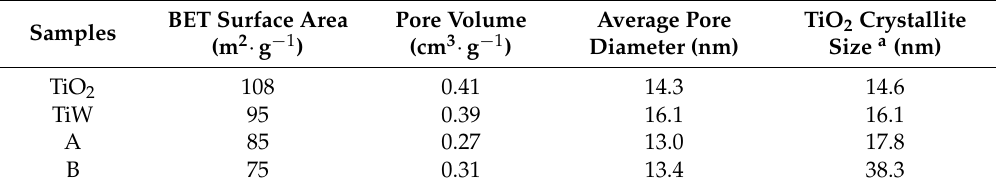
Table 1. Texture properties of the catalysts A and B and their materials.